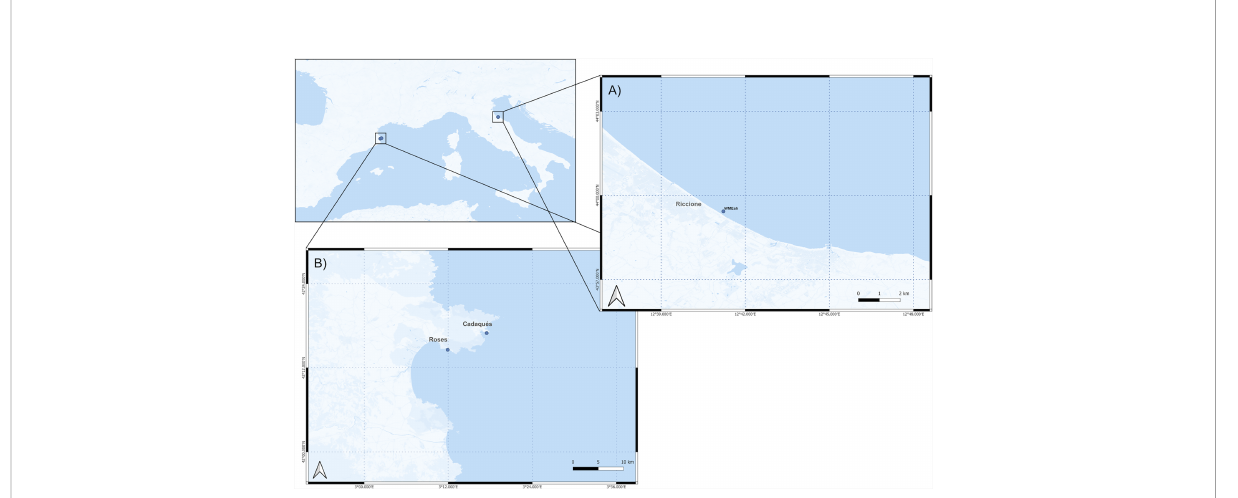
FIGURE 1 Sampling site description. Maps of the Riccione site (A) at the WMesh location (lat. 43.99049, lon. 12.686993) and of the Cap de Creu site (B) near Cadaque ́ s (lat. 42.282752, lon. 3.291442) and near Roses (lat. 42.243116 lon. 3.198715). Sampling sites are represented as blue dots. All maps were created with the QGIS open-source tool